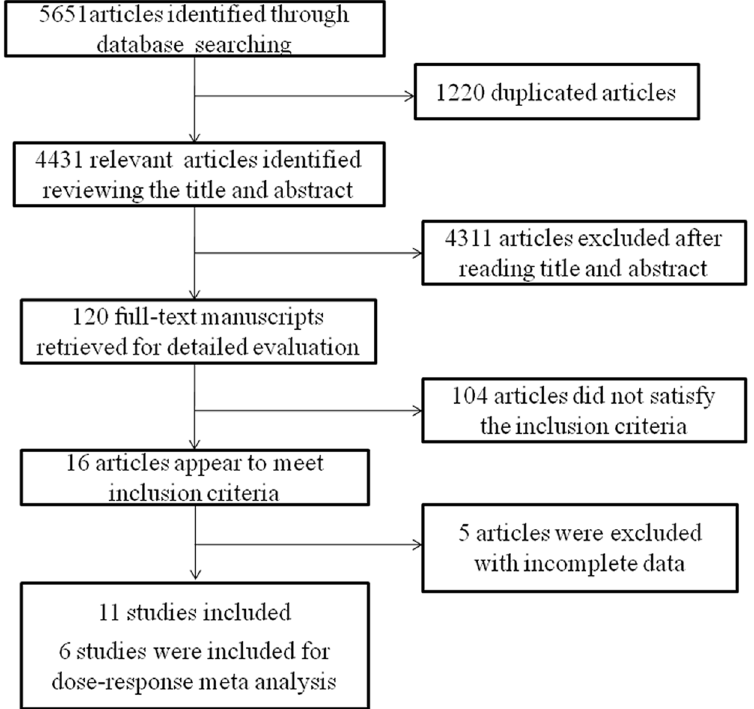
Figure 1. Flow chart of study